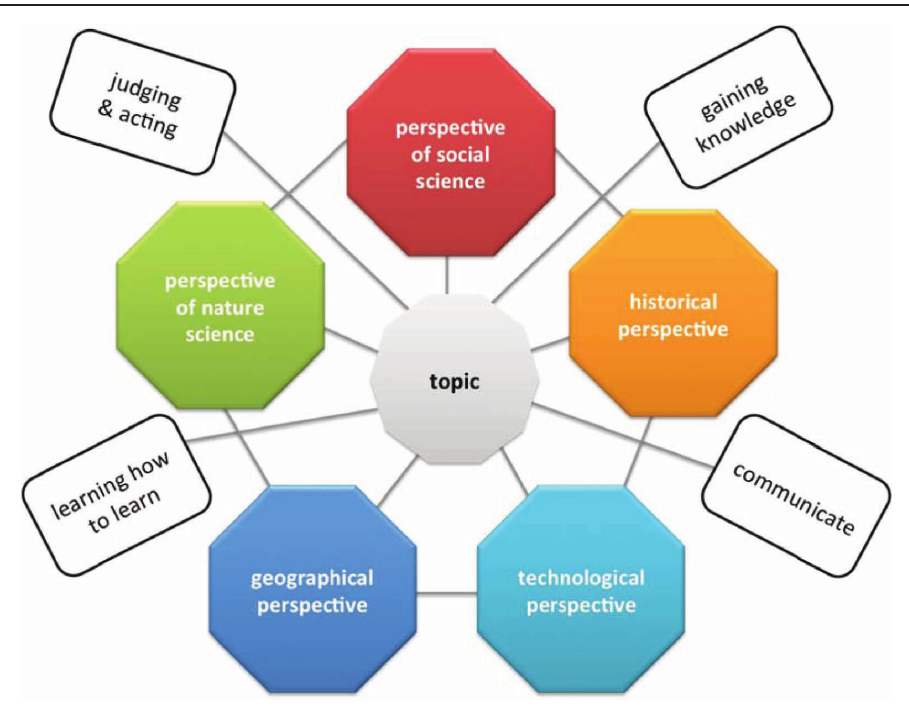
Figure 1: Perspectives of Sachunterricht Source : based on GDSU